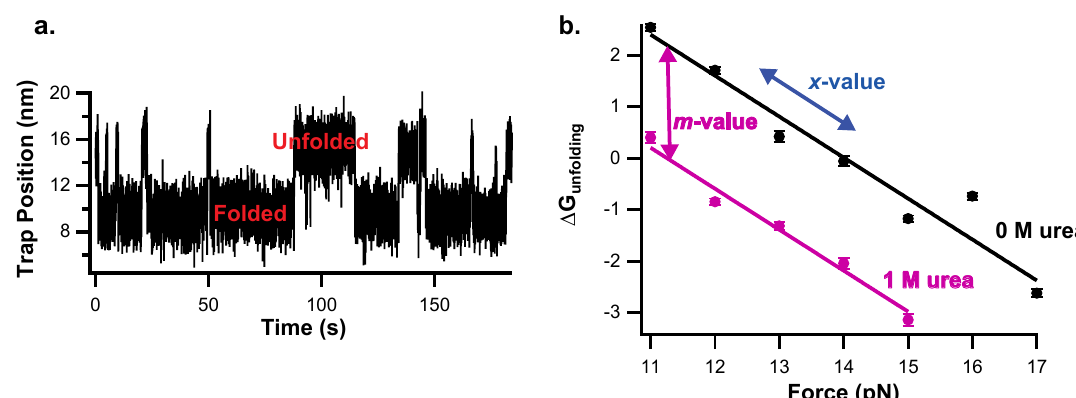
Figure 3. Chemo-mechanical unfolding to explore protein folding thermodynamics of Acyl CoA Binding protein (ACBP, as studied in reference [12], which is described in the applications section below). ( a ) Example of experimental hopping data where ACBP is held at a constant force and observed to hop between folded and unfolded states. ( b ) Chemo-mechanical unfolding data showing ∆ G unfolding as a function of force in 0 and 1 M urea. The x -value is determined from the slope of ∆ G unfolding vs. force and the m -value is determined from the slope of ∆ G unfolding vs. [urea], or the di ff erence between the 0 M urea and 1M urea data shown